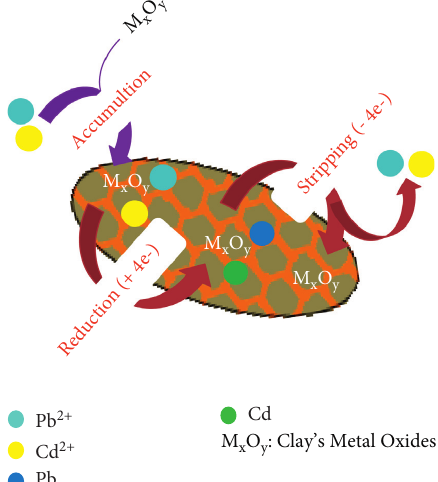
Figure 10: Schematic representation of detection mechanism for Pb 2+ and Cd 2+